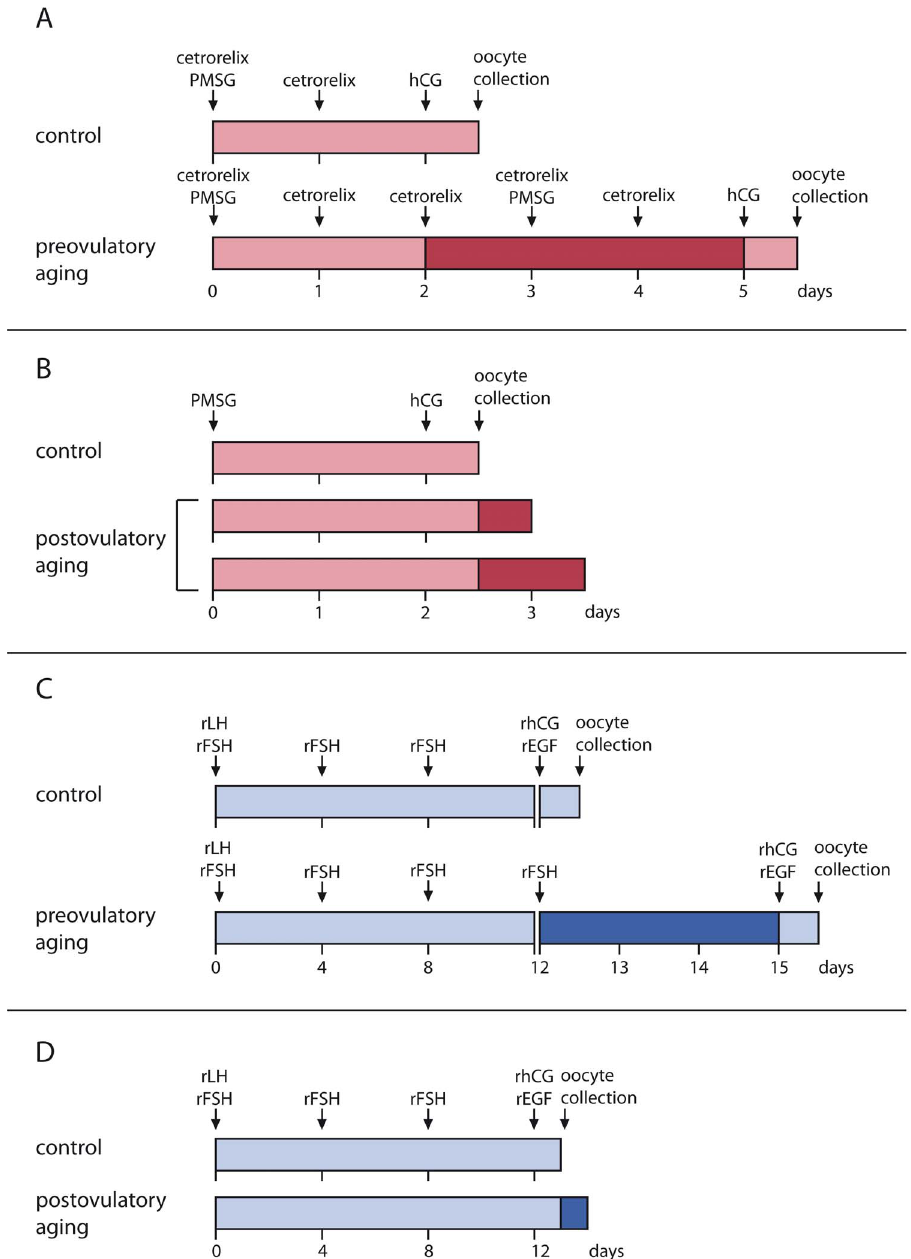
Figure 1. Timeline of pre- and postovulatory aging in vivo (A, B) and in vitro (C, D). A, B) For in vivo maturation of oocytes, follicle maturation was stimulated by PMSG on day 0. Ovulation was induced by hCG 48 h later. Control oocytes were collected from the ampullae the next morning. For preovulatory in vivo aging, ovulation was delayed by the GnRH antagonist cetrorelix for 3 d (A). Oocytes for postovulatory aging were collected at the same time as controls and cultured in M2 medium for further 12 or 24 h (B). C, D) For in vitro growth and maturation of oocytes, preantral follicles were cultured for 12 d in the presence of rLH and rFSH to the antral follicle stage. Ovulation was induced with rhCG/rEGF and control oocytes were collected after 18 h. To obtain preovulatory-aged oocytes, ovulation was induced with rhCG/rEGF on day 15 of follicle culture instead of day 12 (C). For postovulatory aging, ovulation was triggered with rhCG/rEGF and oocytes were incubated for additional 12 h before collection (D). doi:10.1371/journal.pone.0108907.g001 number of oocytes with a germinal vesicle (GV), germinal vesicle some outgrowing theca- and granulosa cells. In stage two breakdown (GVBD) and first polar body (MII) after rEGF/rhCG (‘‘diffused’’) the spherical follicle conformation is lost and stimulation at time of harvest. granulosa cells proliferate and flatten out on the culture well. In stage three (‘‘antrum’’) cumulus and mural granulosa cell differentiation and formation of antral-like-cavity structures becomes visible. The maturation rate was determined by the